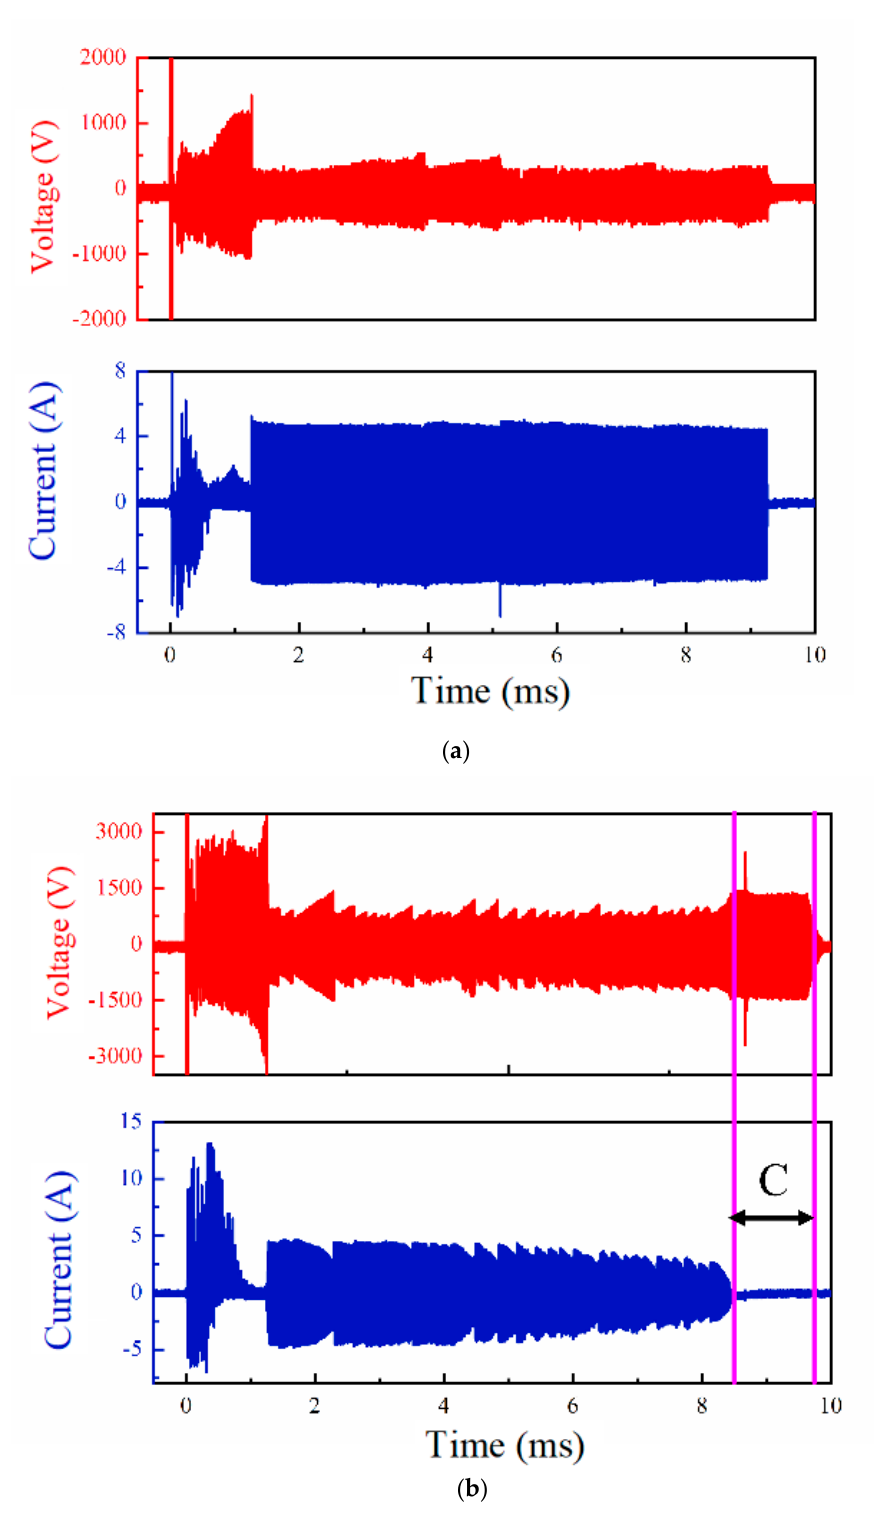
Figure 8. Voltage and current waveforms at Δ p = 20 Torr and Δ p = 550 Torr: ( a ) voltage and current waveforms at Δ p = 20 Torr; ( b ) voltage and current waveforms at Δ p = 550 Torr.